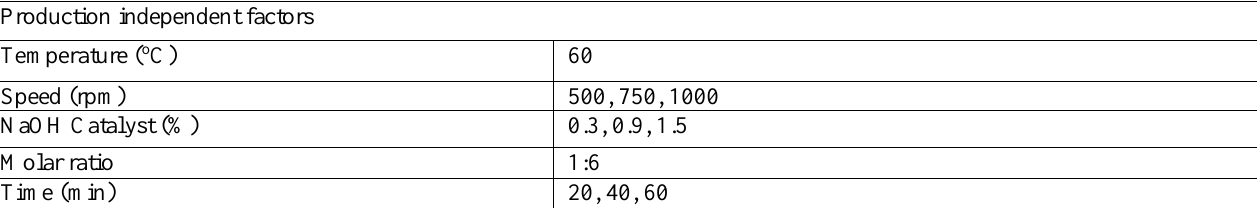
Table1: Design levels with independent variables.